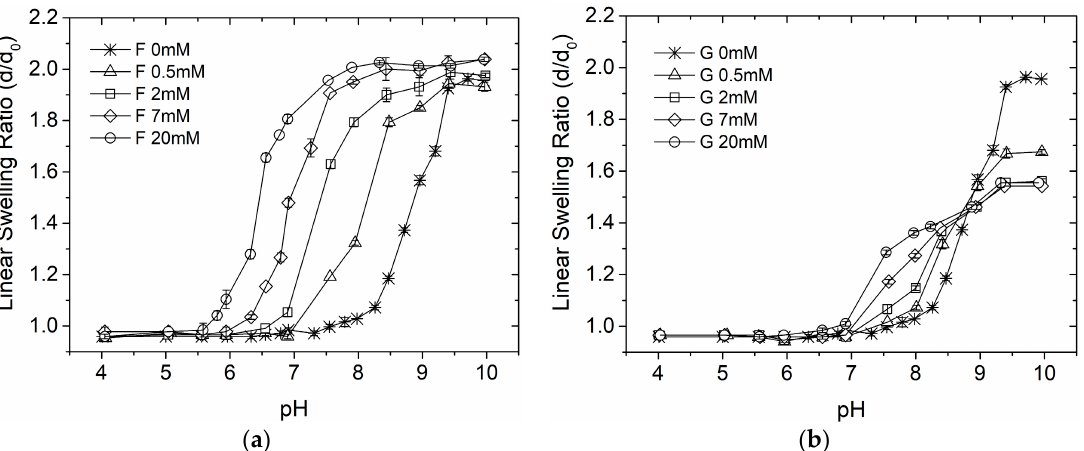
Figure 1. Equilibrium swelling of p(AAM- co -MPBA) hydrogels in buffers of various pH, and at varying concentrations of ( a ) fructose (F); and ( b ) glucose (G). All measurements were performed in duplicate. Replotted from Ref. [37].